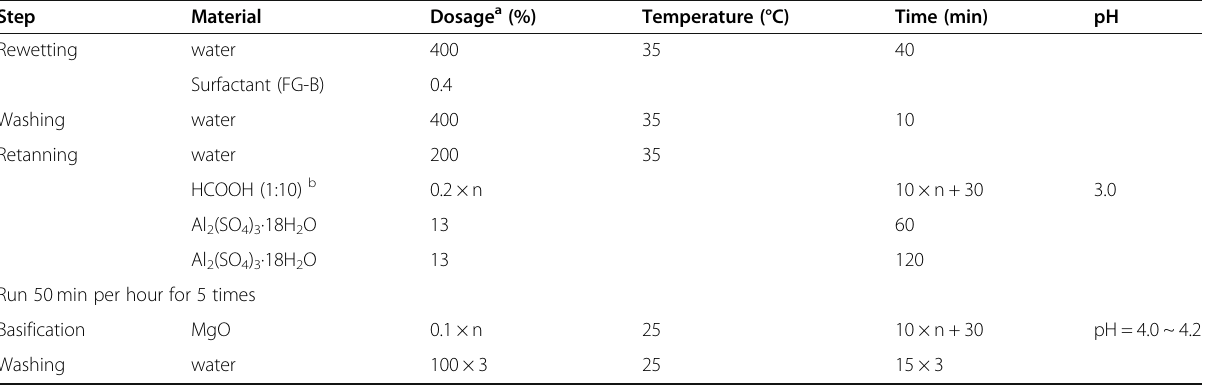
Table 1 Pretreatment processes of wet-blue